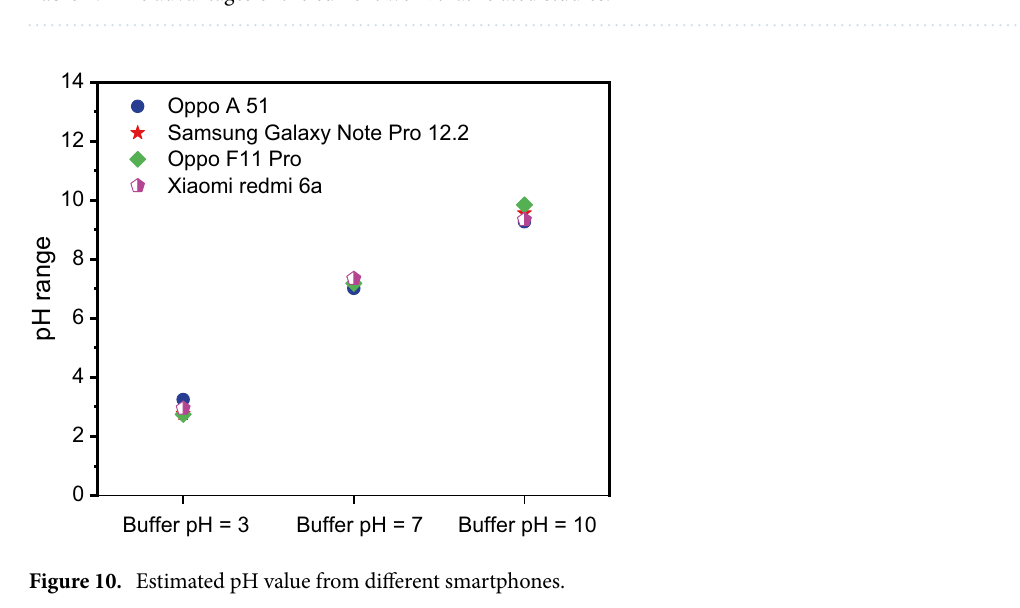
Table 2. The advantages of the current work that related studies.